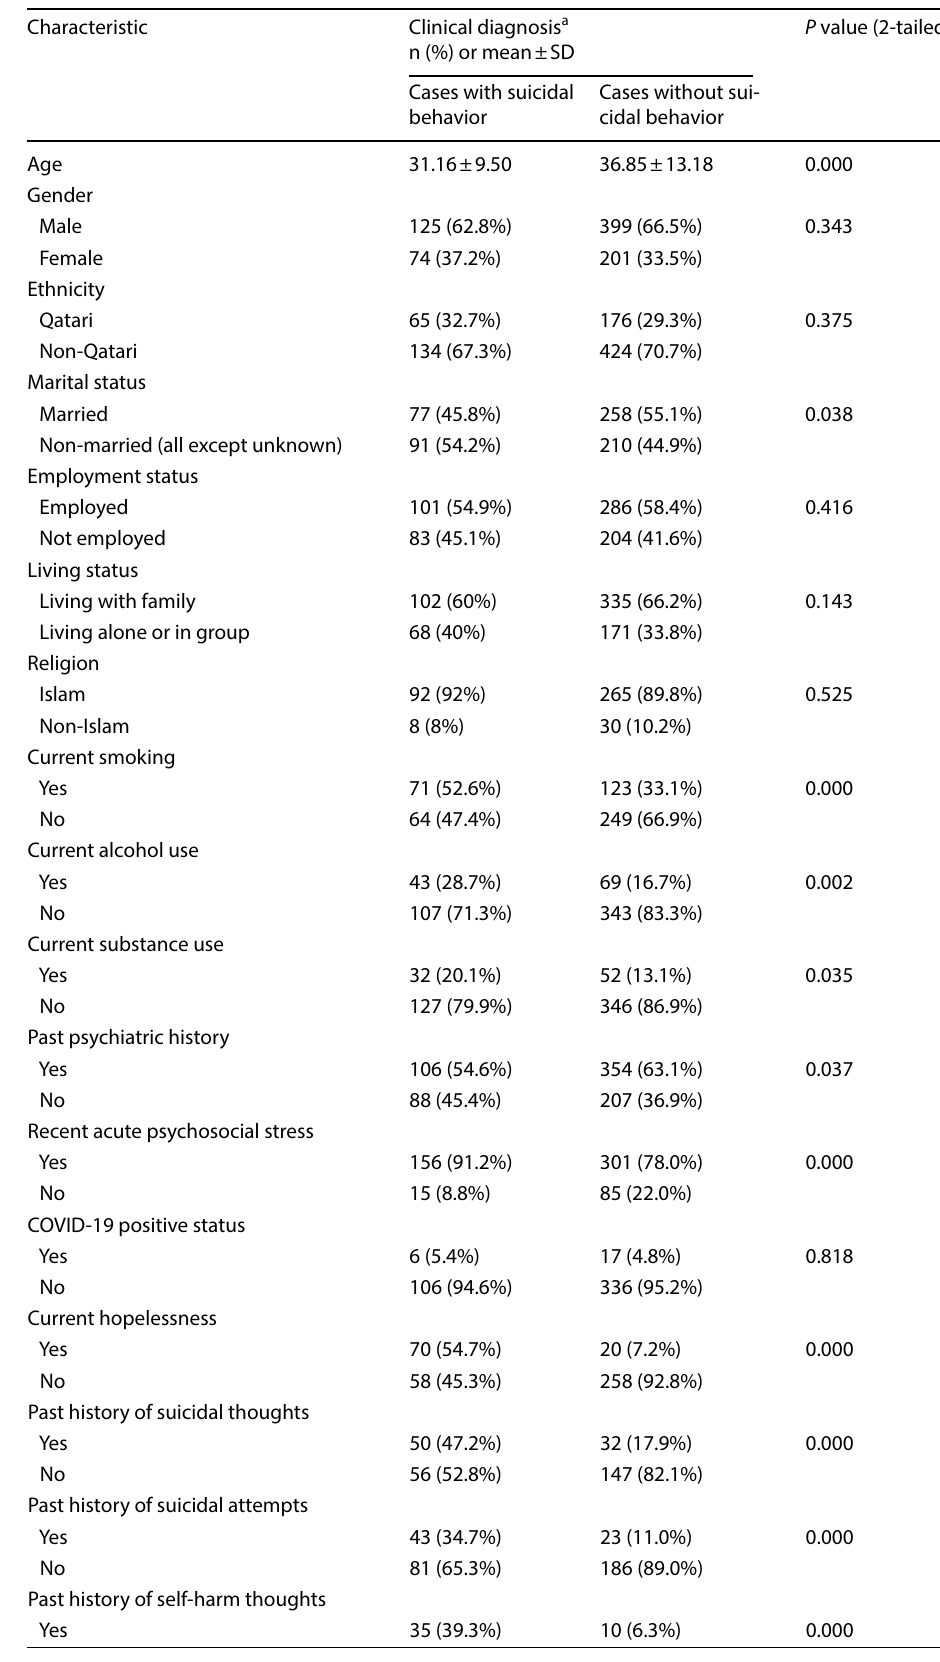
Table 4 Univariate analysis comparing those with suicidal behavior and those without (N = 799)